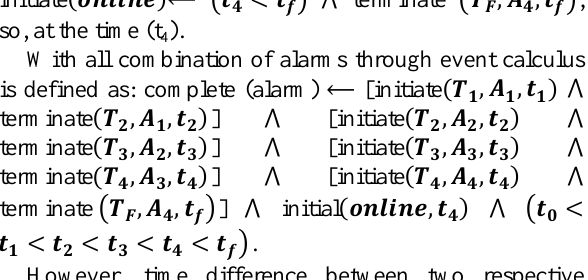
The processing function of DAGSVM is analyzed in the light of mathematical foundation for establishing relation with event-calculus technique. The tetra stages of alarm series are defined according to the significance of